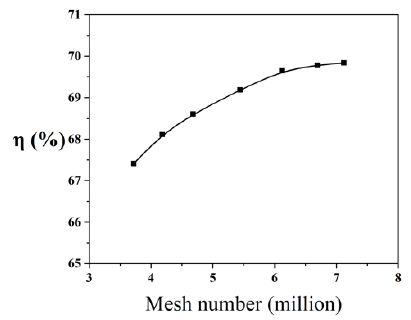
Figure 4. Effect of mesh number on efficiency.